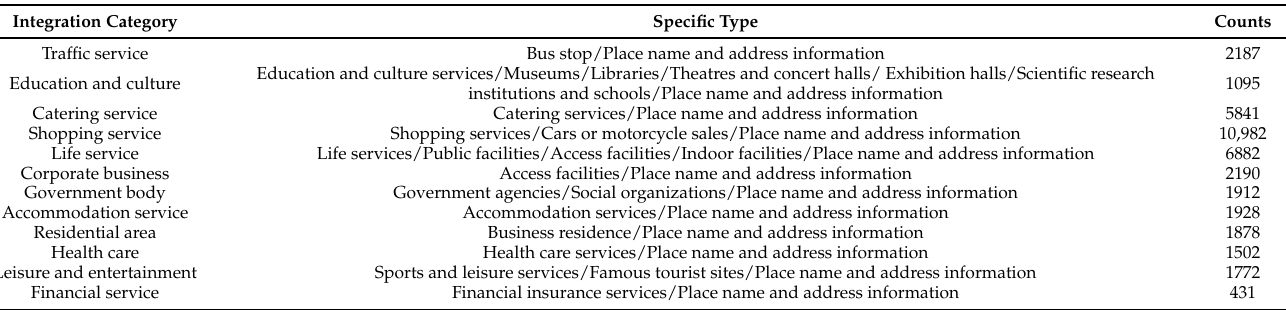
Table A1. POI data classification.